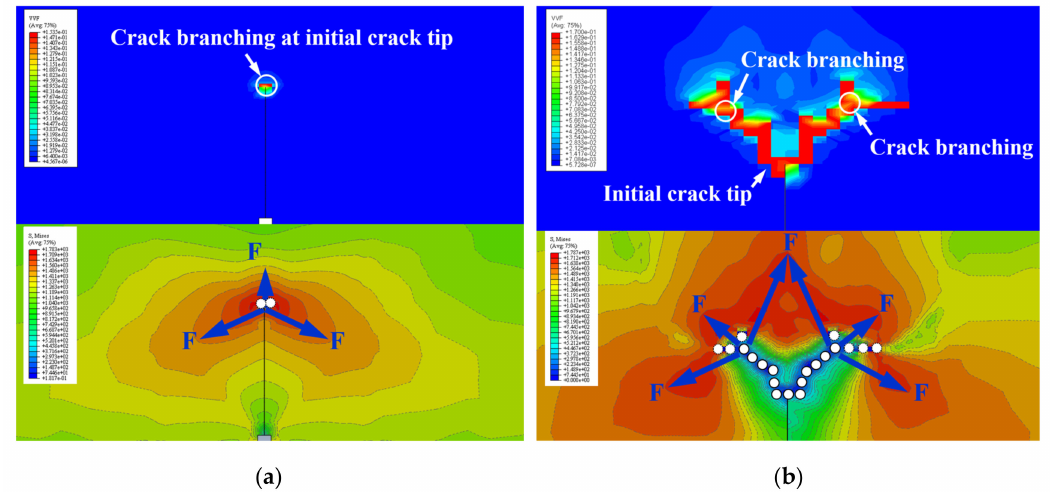
Figure 13. The void volume fraction (VVF) and stress distributions when the first crack-branching event occurs ( a ) and the second and third crack-branching events ( b